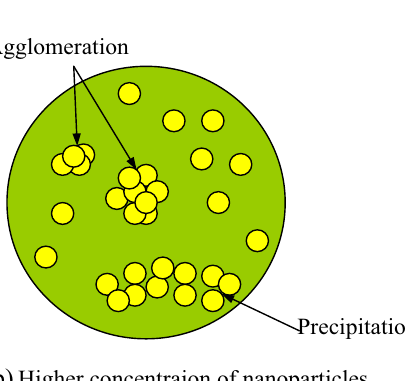
Figure 10 Dispersion of Al 2 O 3